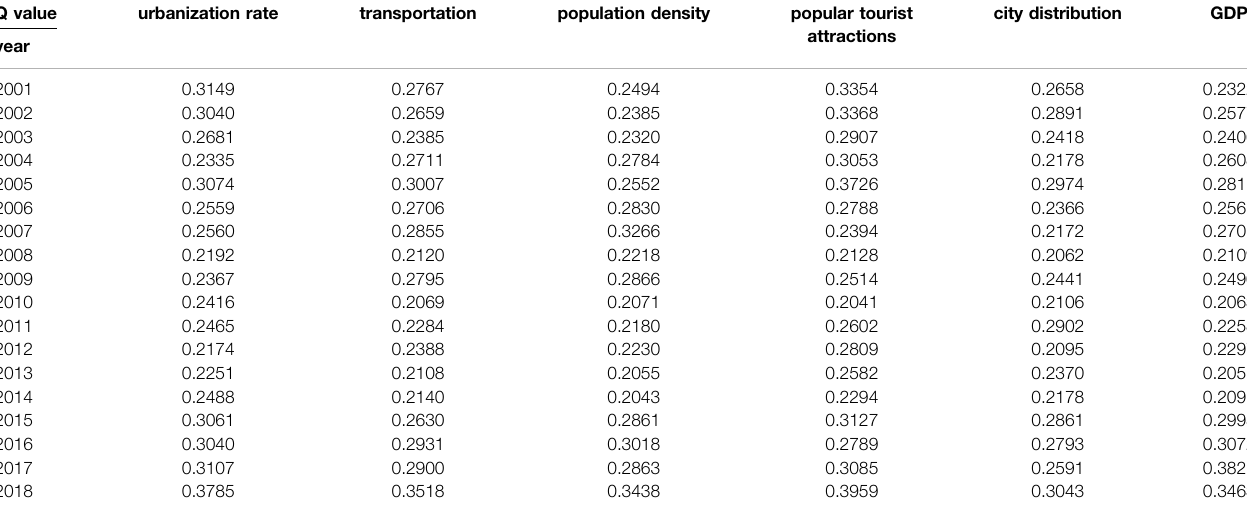
TABLE 3 | Effects of different anthropogenic factors on vegetation cover in Guanzhong, Central China from 2001 to 2018 (a summary of Q values).